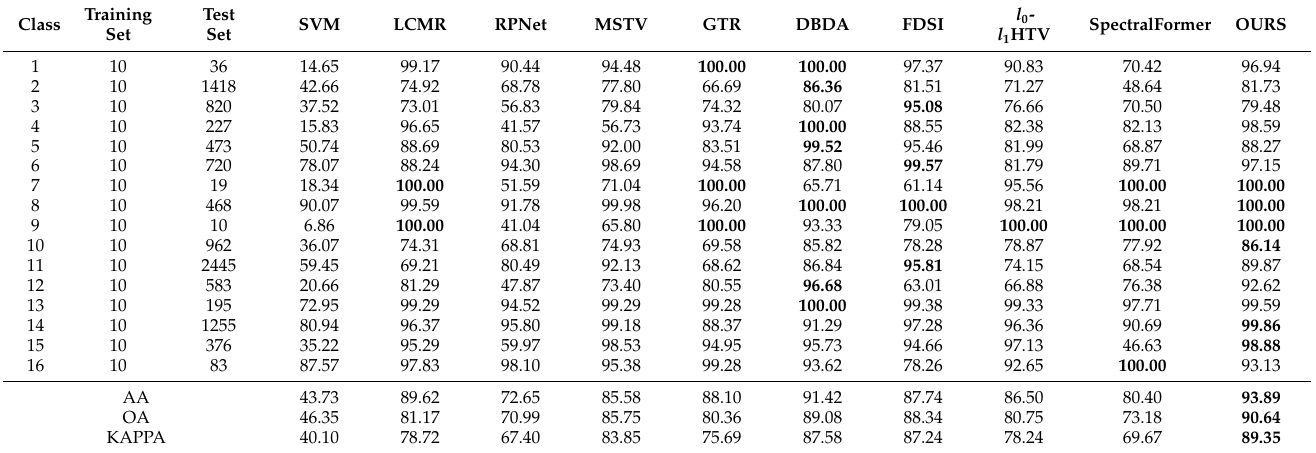
Table 2. Experimental results (percentage) on Indian Pines dataset obtained by different methods. The best results are highlighted in bold.